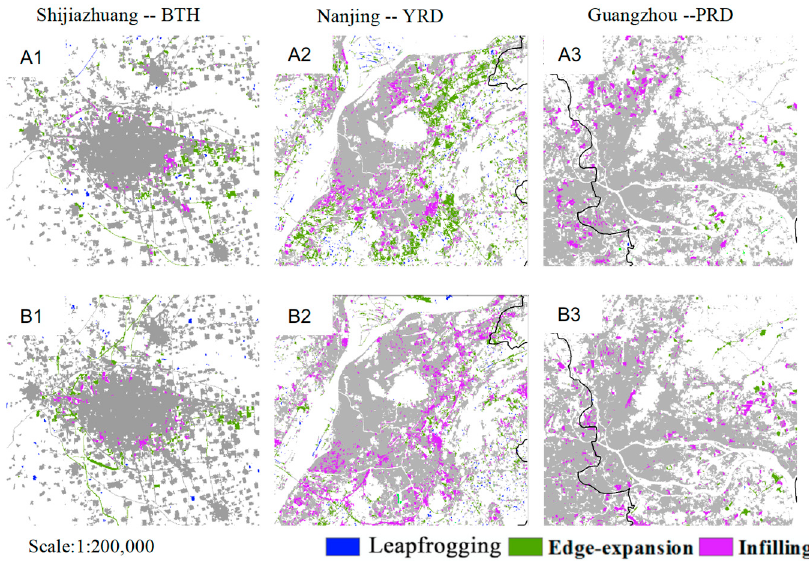
Figure 3. Examples of the different morphological models of urban expansion in cities of the three urban megaregions. ( A1 – A3 ) were results in 2000–2005, ( B1 – B3 ) were results in 2005–2010.